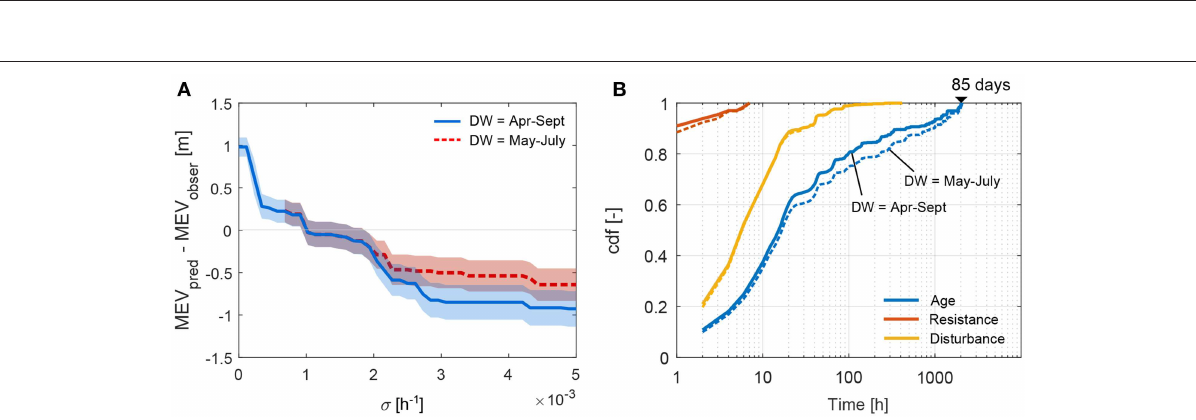
FIGURE 10 | Results of the model calibration. (A) Difference between the minimum elevation at which the model predicts vegetation (MEV pred ) and the observed value (MEV obser ) for different growth rates, σ (Equation 1). Lines (solid and dashed) indicate the mean value of the MEV averaged over the cross sections analyzed and the light colored shade the standard deviation. (B) Cumulative density distribution of the age and relative resistance (Equation 1) of vegetation that did not establish (unsuccessful recruitment events). The disturbance (inundation duration) that caused plant mortality is also reported. Here solid lines indicate results obtained with a dispersal window (DW) between April and September, while dashed lines refer to a DW between May and July.